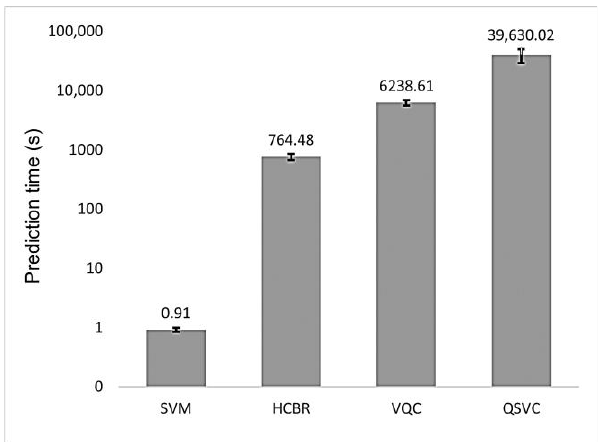
Figure 9. Mean prediction time (in seconds) for HCBR (764.48), VQC (6238.61), and QSVC (39,630.02) as compared to the SVM (0.91) classifier. For the quantum classifiers, we reported the prediction time obtained with our local machine. The vertical scale is logarithmic. The vertical black bars on top of each “ column ” represent the standard deviation (std) of the classifier: SVM (0.07), HCBR (93.20), VQC (613.58), and QSVC (10,736.88).